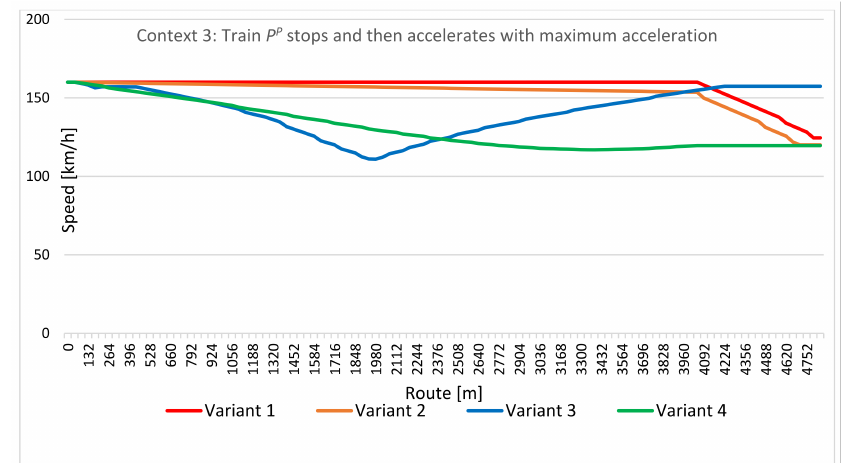
Figure 13. Speed profiles of P N for different movement variants; context 3 (source: own